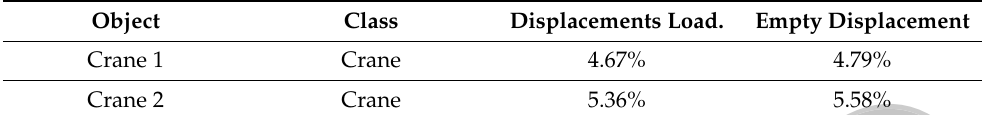
Table 3. Status report for mass mode.